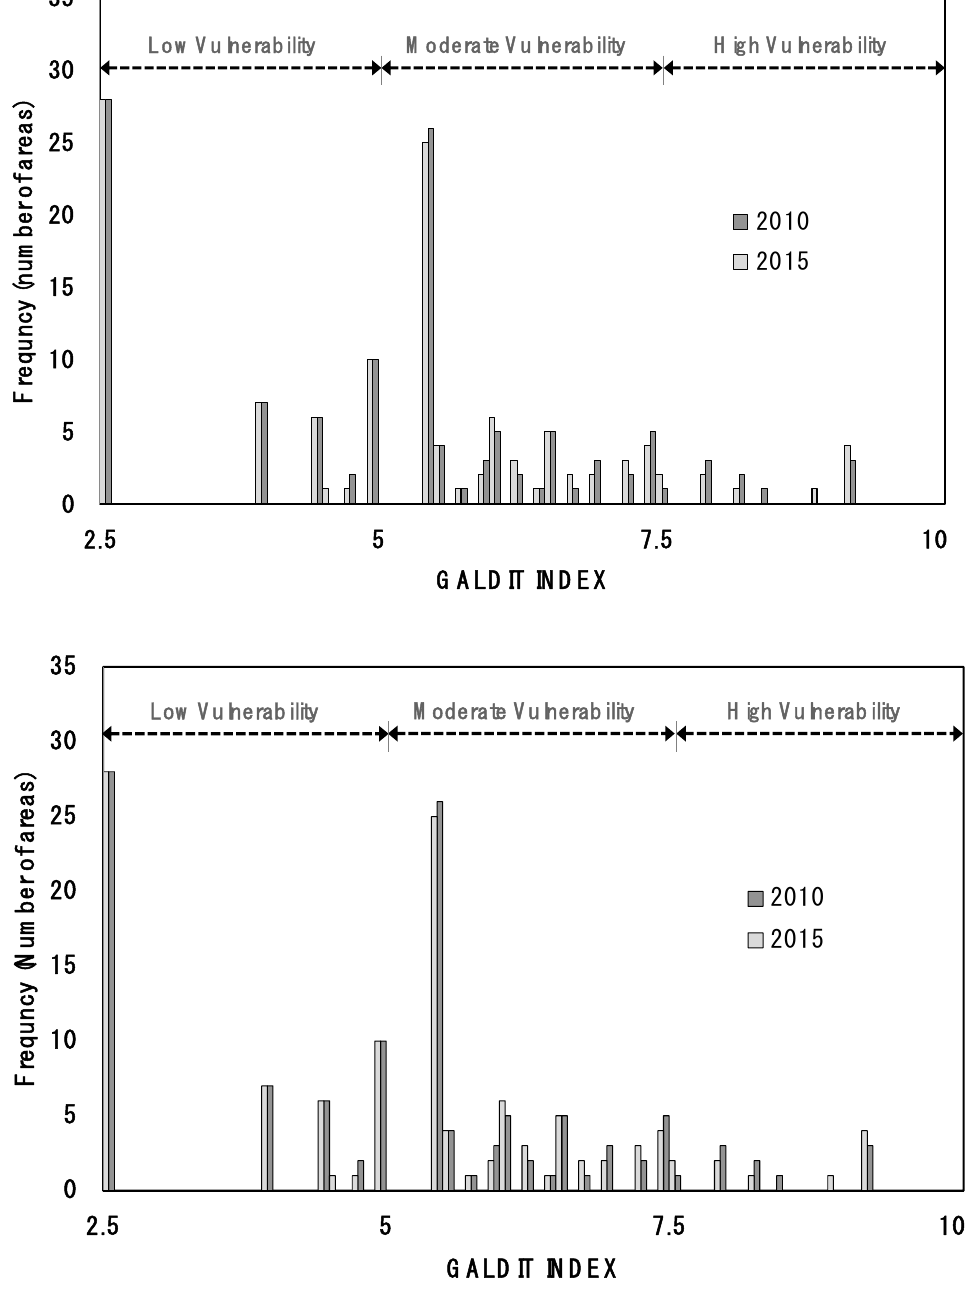
Figure 5. Histogram of GALDIT index distribution for the years 2010 and 2015.